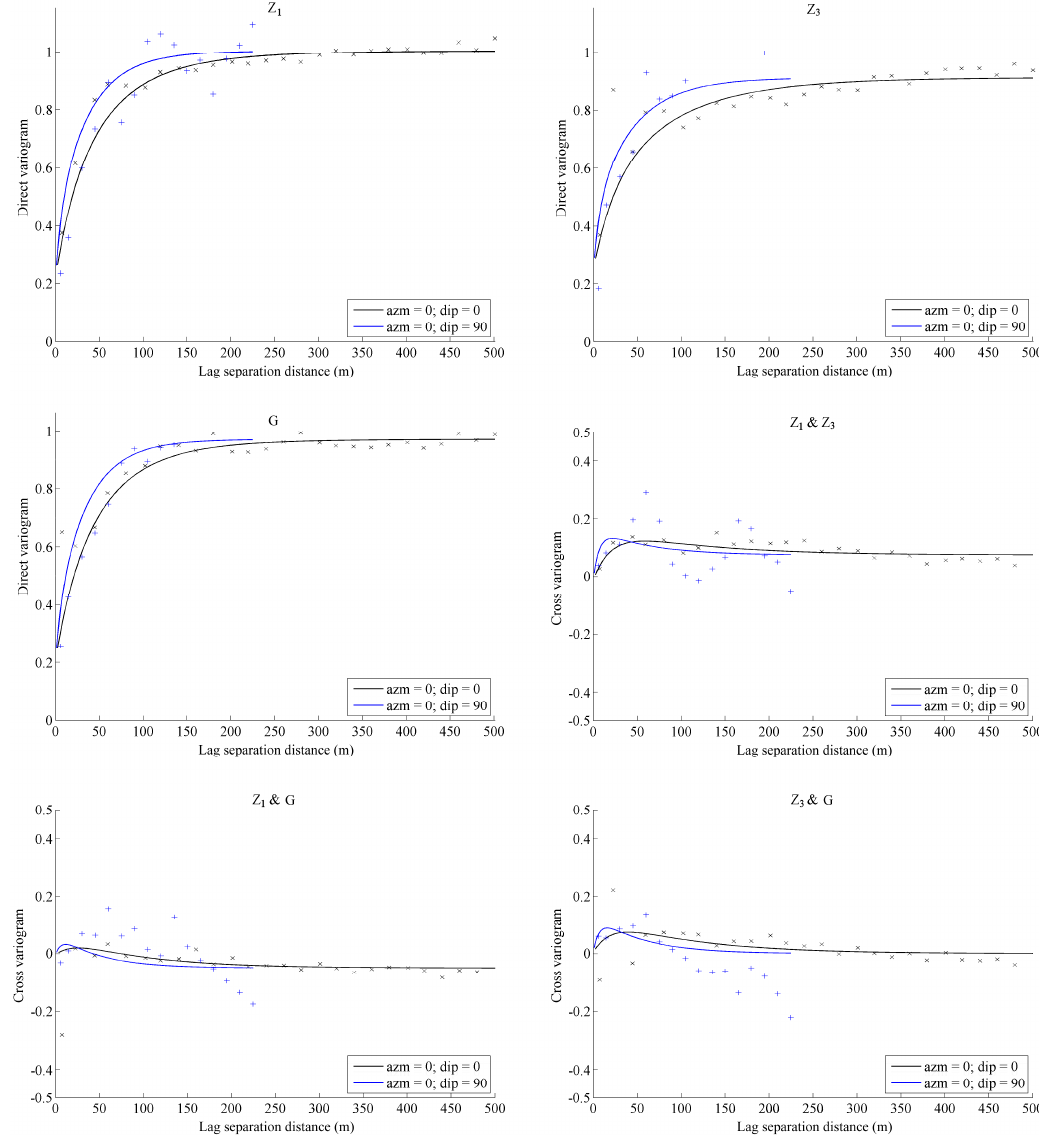
Figure 3. An example of experimental (crosses) and fitted (solid lines) direct and cross-variograms for the PPMT-transformed variables of Z 1 , Z 3 , and G, along the horizontal (black) and vertical (blue) directions.